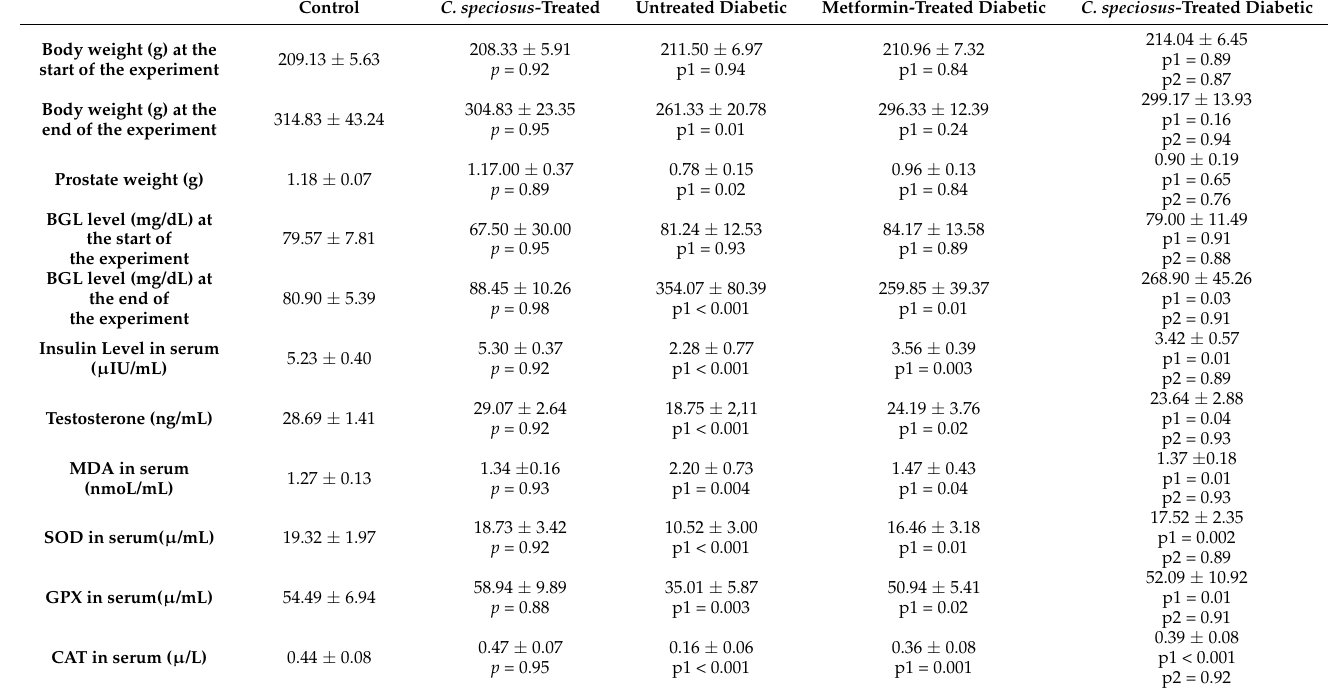
Table 3. Effect of C. speciosus on the blood glucose level (BGL), insulin, oxidants/antioxidant profile and testosterone in the serum of the studied